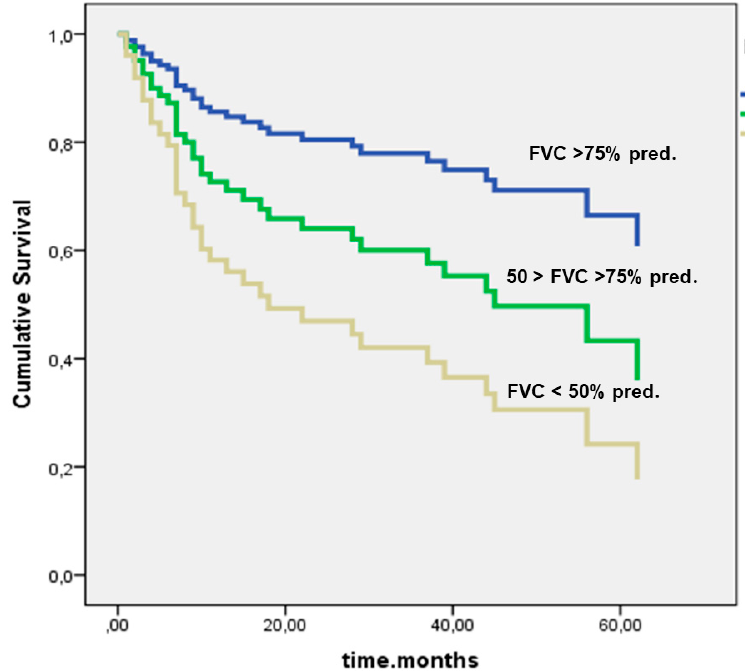
Figure 7. Cumulative survival in dependency of FVC at baseline ( p = 0.008). Given are Kaplan–Meier curves for cumulative survival, based on definite outcome data. Abbreviations: FVC—forced vital capacity, % pred.—percentage of predicted